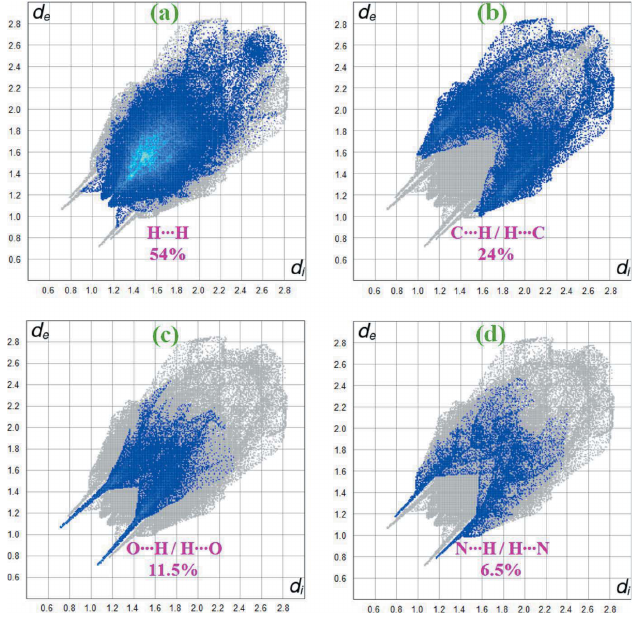
Figure 8 Two-dimensional fingerprint plots for the ( a ) H (cid:2)(cid:2)(cid:2) H (54%), ( b ) C (cid:2)(cid:2)(cid:2) H/ H (cid:2)(cid:2)(cid:2) C (24%), ( c ) O (cid:2)(cid:2)(cid:2) H/H (cid:2)(cid:2)(cid:2) O (11.5%) and ( d ) N (cid:2)(cid:2)(cid:2) H/H (cid:2)(cid:2)(cid:2) N (6.5%) contacts in the title